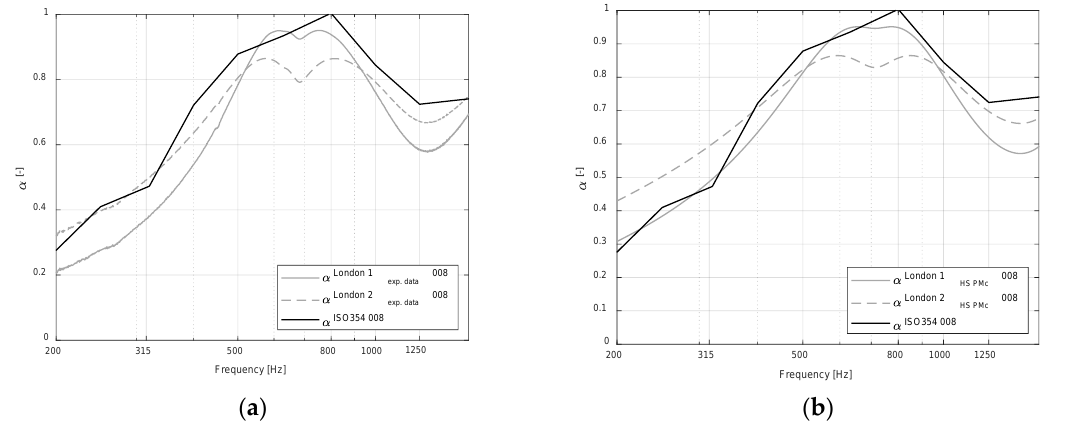
Figure 12. Experimental and theoretical sound-absorption curves in diffuse field conditions, considering: ( a ) the directly measured normal incidence sound absorption, and ( b ) for Horoshenkov–Swift model with corrected macroscopic parameters.